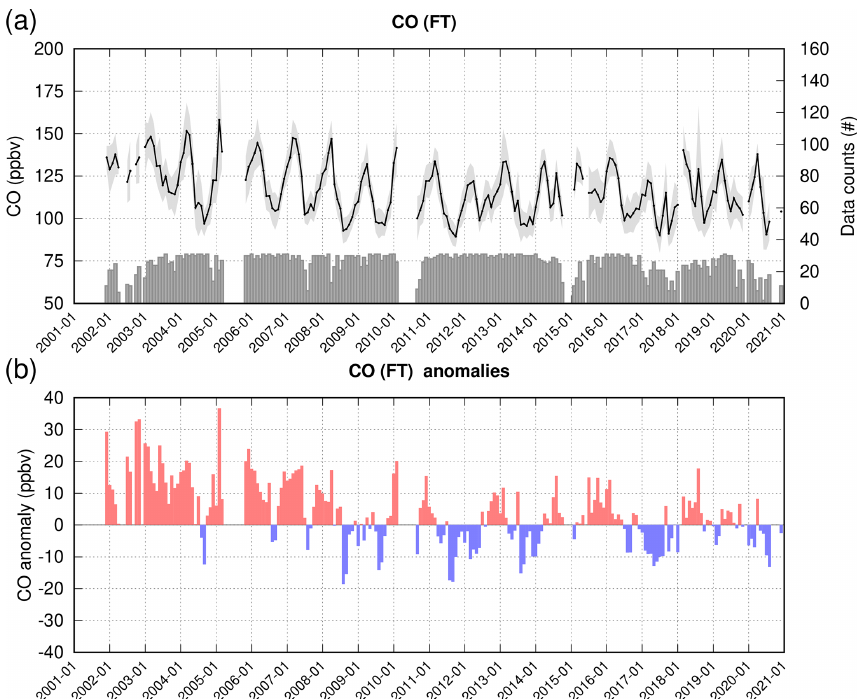
Figure B2. Monthly time series for 2001–2020 of CO for the free troposphere over Frankfurt (a) . The grey bars represent the number of daily profiles used to calculate the monthly means shown in black. Grey shading represents the standard deviation for each month. (b) The monthly anomalies calculated with respect to the reference average period of 2016–2019 in the free troposphere (830–350hPa). Please note that the date format used in this figure is